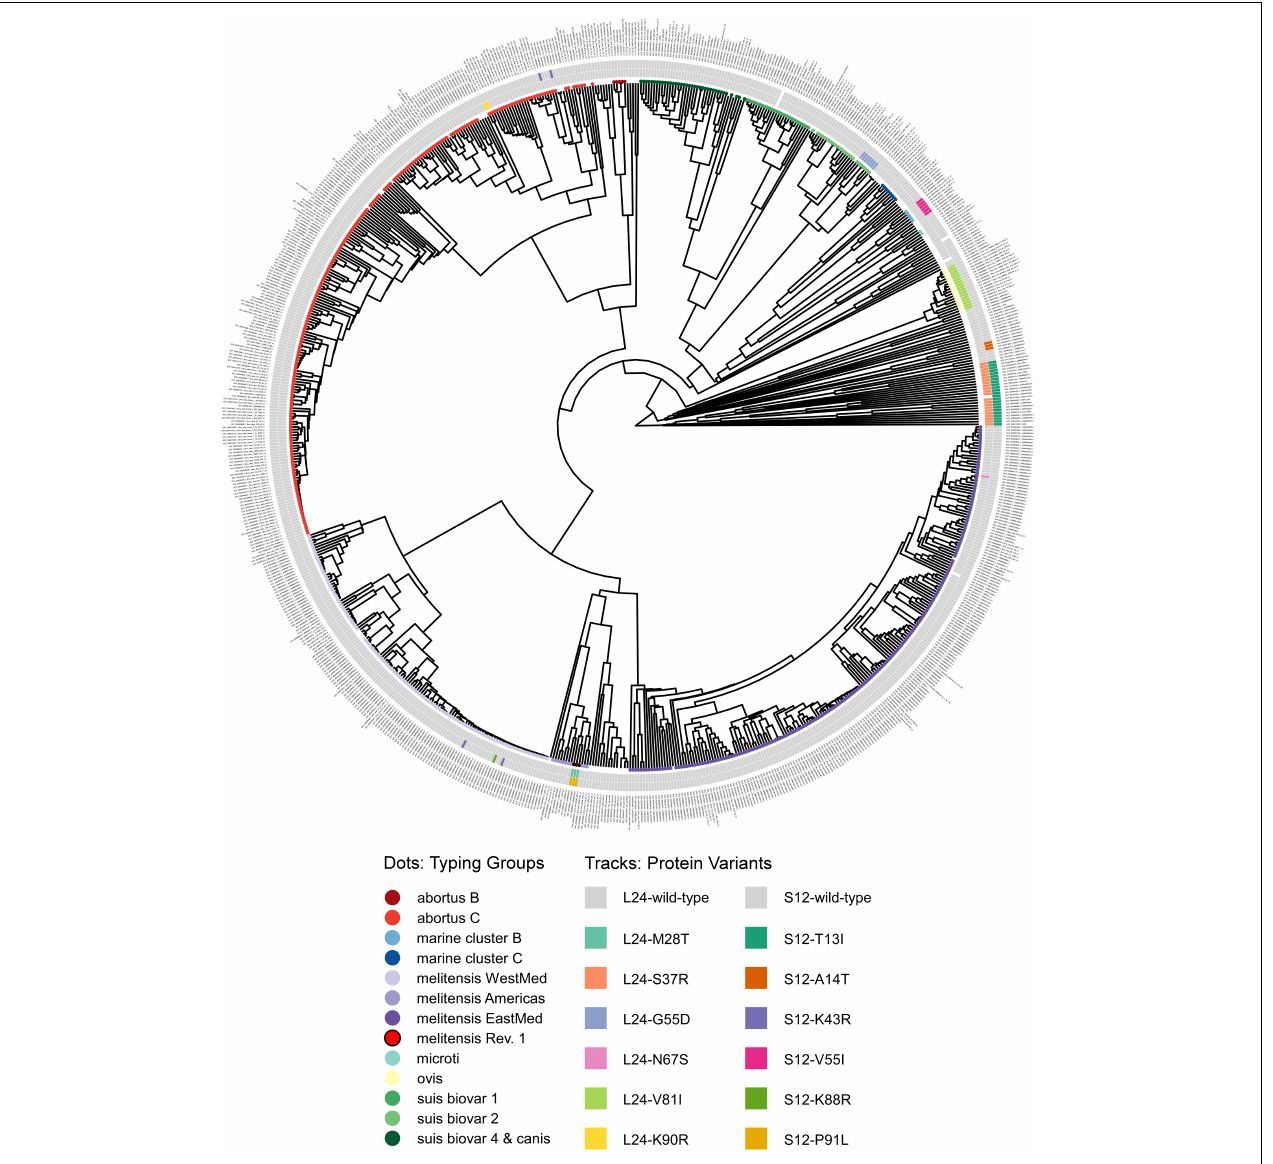
FIGURE 6 | Phylogram of protein sequence presence in the NCBI pan proteome of the genus Brucella . Genomes were classified by in silico MLVA and MLST into typing groups (colored circles as leaves on the unrooted phylogram; white: no or non-congruent typing result). The tracks show ribosomal protein variants for L24 (inner) and S12 (outer) identified by blastP (white: no significant